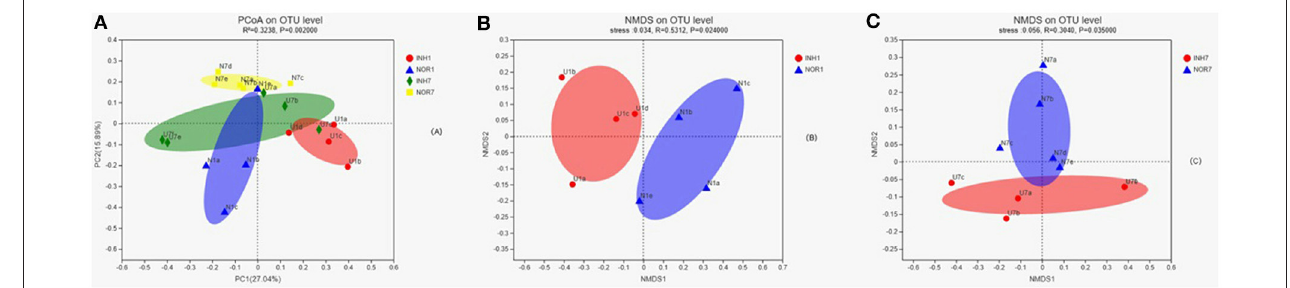
FIGURE 5 | (A) In PCoA, the X-axis and Y-axis represent the two selected principal coordinate axes, and the percentage represents the explanatory value of the principal coordinate axes to the difference in sample composition; the X-axis and Y-axis scale is a relative distance, with no practical significance. Points of different colors or shapes represent samples of different groups. The closer the two sample points are, the more similar the species composition of the two samples is. Panels (B,C) the results of NMDS analysis. Points with different colors or shapes represent samples of different groups. The closer the two sample points are, the more similar the species composition of the two samples is. Horizontal and vertical coordinates represent relative distances and have no practical significance. Stress is based on a test of the strengths and weaknesses of NMDS analysis results. It is generally believed that stress < 0.2 can be represented by a 2d NMDS point graph, which has certain explanatory significance. When stress < 0.1, it can be considered a good ranking; when stress < 0.05, it is